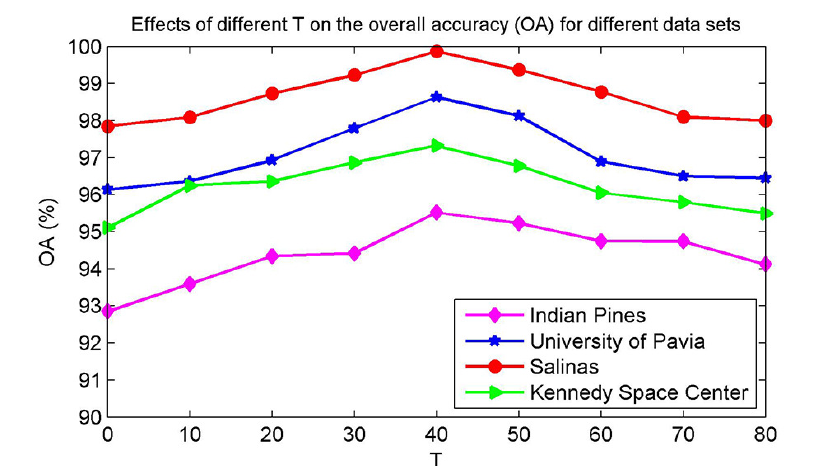
Figure 7. Effects of the number of generated pseudo-labeled samples ( T ) on the overall accuracy (OA) for different data